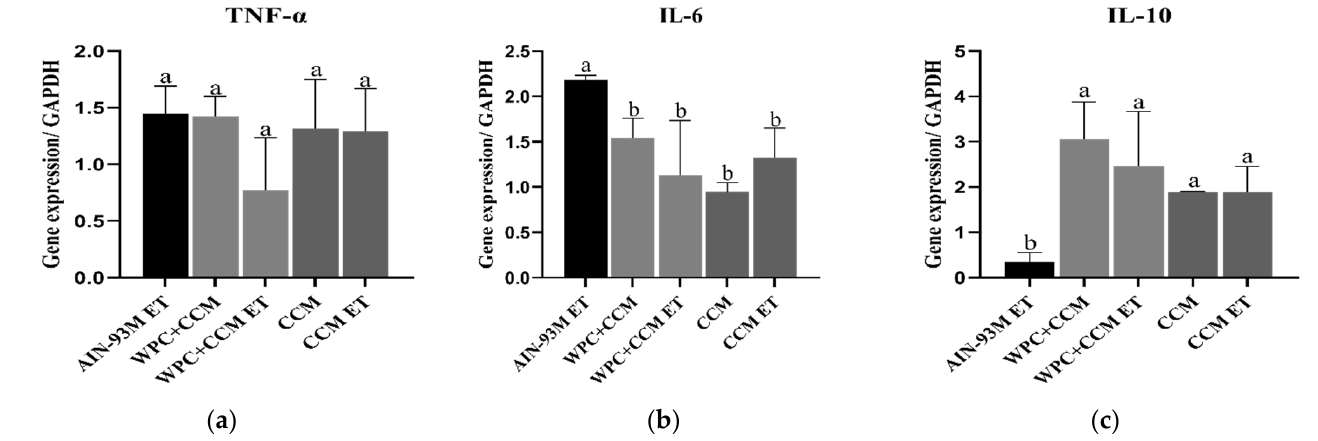
Figure 3. Gene expression of TNF- α , IL-6, and IL-10 in muscle. AIN-93M: group not submitted to